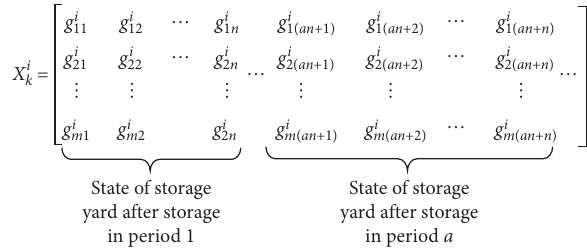
Figure 8: Dimensions of the matrix variable of the values than an average value will have a lower crossover rate to allow their good genes to be kept in offspring population. On the contrary, indi- viduals with a lower fitness rate will have higher crossover rates. The operator can ensure the di- versity of the population and prevent it from falling into a local optimum. The formula for calculating